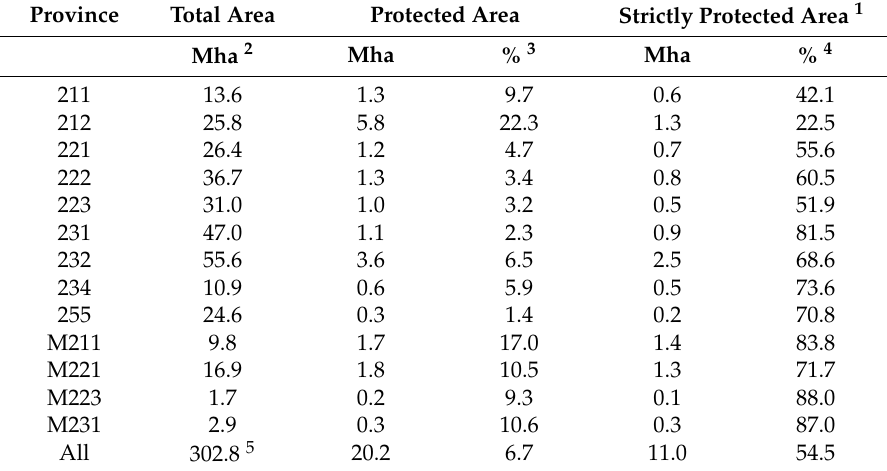
Table 1. Total IUCN protected area.